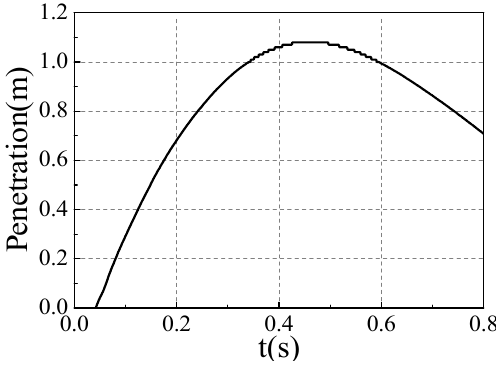
Figure 8. The time-history penetration.